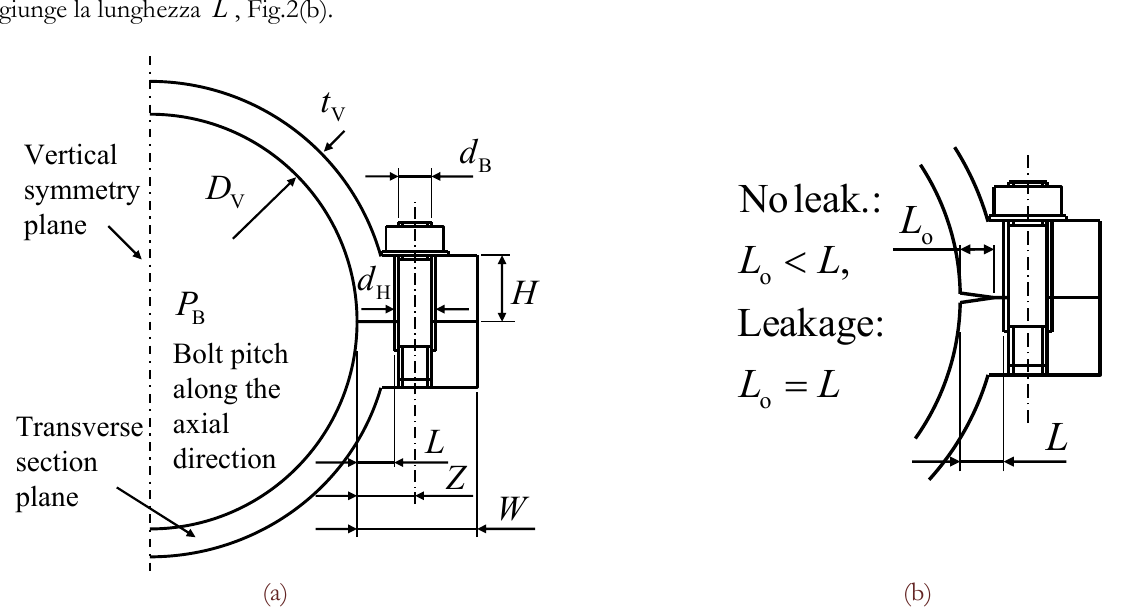
Figura 2: (a) Dimensioni principali della geometria della flangia. (b) Condizione di